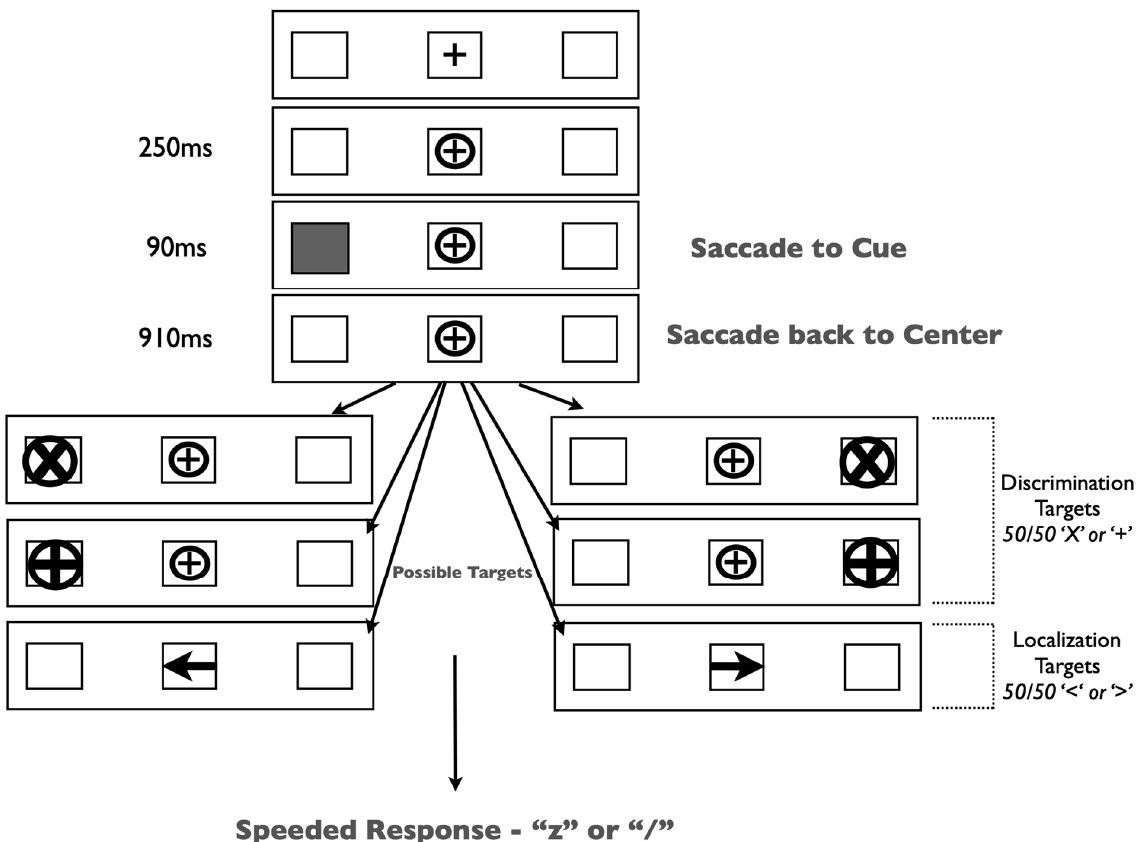
Figure 2. Methods figure depicting the time course of a trial. Duration of each subsequent event is depicted to the left of the image. Discrimination targets were counter-balanced for location (left or right placeholder) and identity (‘X’ or ‘+’). Localization targets were counter-balanced for direction (left or right pointing). The relative frequency of target type was manipulated between groups. This image is not to scale, so the relative size of features may be misrepresented.